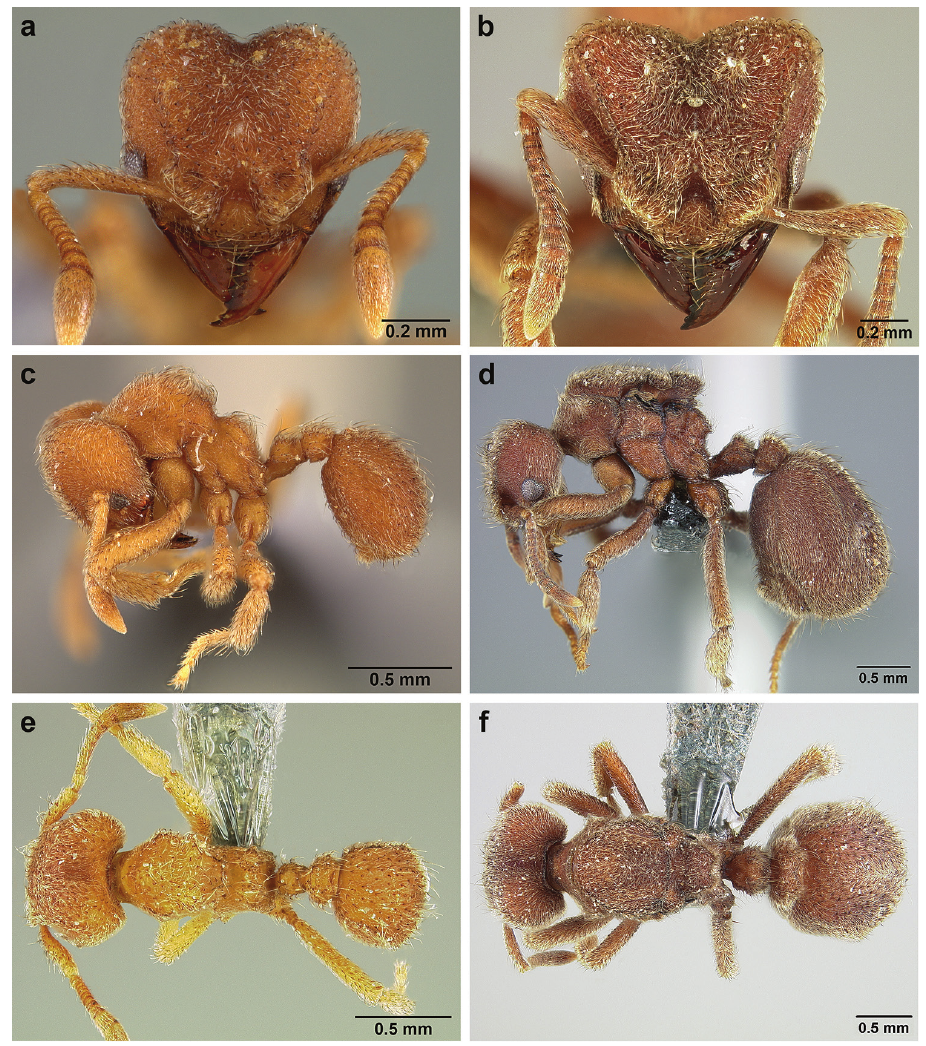
Figure 48. S. parvulus worker and queen; head, lateral profile, and dorsal view. Worker (USN- MENT00446157) ( a, c, e ). Queen (USNMENT01125594) ( b, d, f ). tidia across largest diameter, in some specimens eyes partially covered with white layer (Figure 6l), in others eyes without white layer. Frontal lobe triangular, relatively small and narrow (FLI=70 ± 3), posterior margin shorter than medial. Frontal carina straight to slightly curved laterally, incomplete, weak, fading before reaching poste- rior cephalic corner. Antennal scape relatively short, not reaching posterior cephalic corner (SI=71 ± 3). Mesosoma. Mesosomal tubercles low and obtuse. Propodeal carinae low and weak, with small posterodorsal